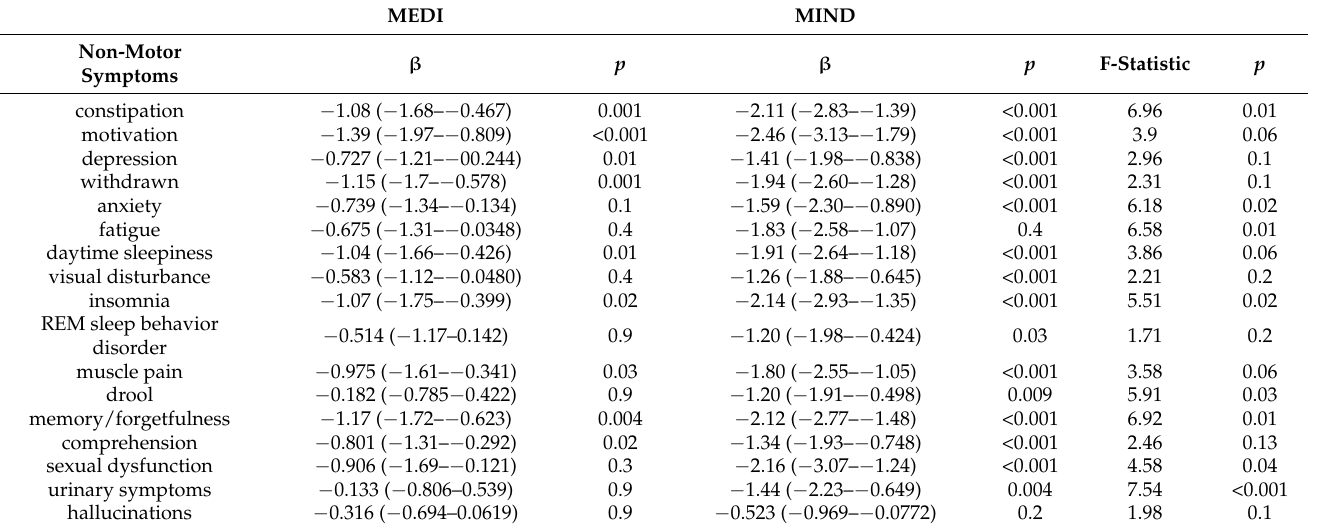
Table 2. Non-motor symptom correlation with MEDI and MIND diet scores. Correlations were assessed via linear regressions adjusted for age, gender, income, and years since diagnosis with a Holm–Bonferroni post hoc